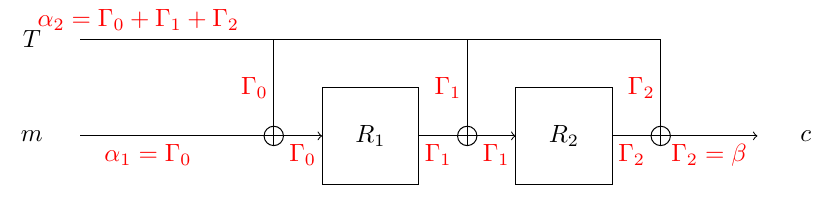
Figure 8: Propagation of masks in a simple two round tweakable block